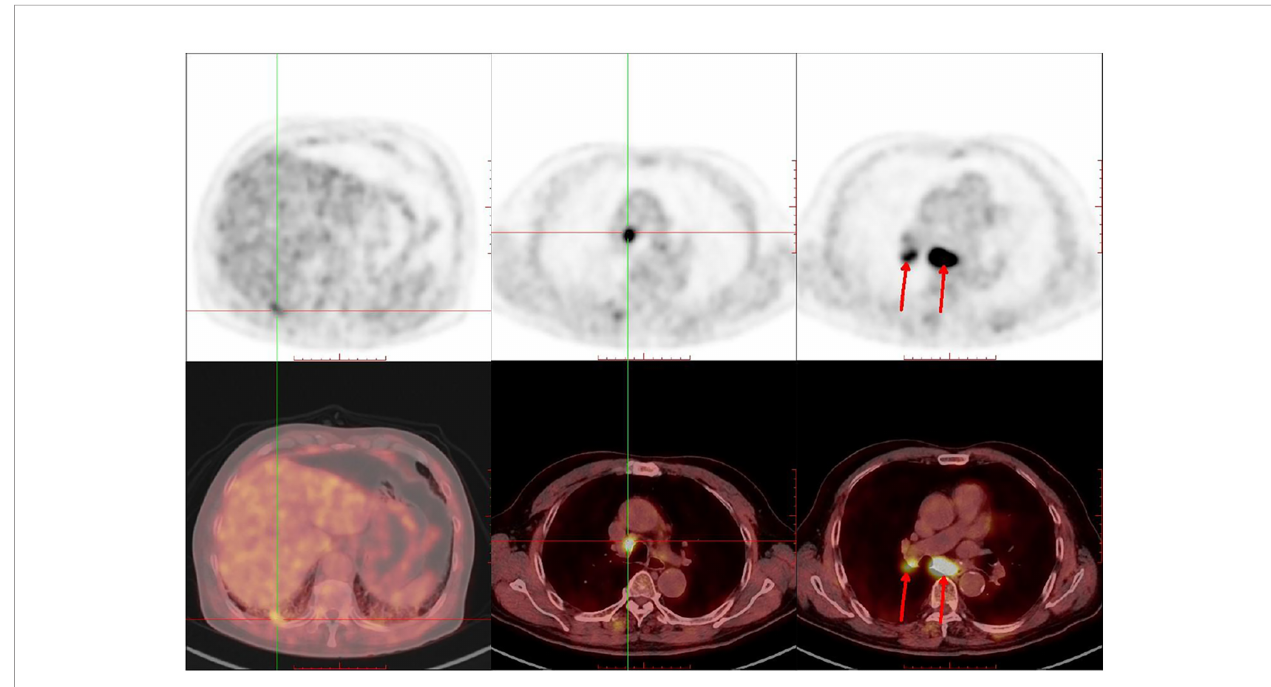
FIGURE 1 | PET/CT revealed a right lower lobe mass and 4R/7 lymphadenopathy before